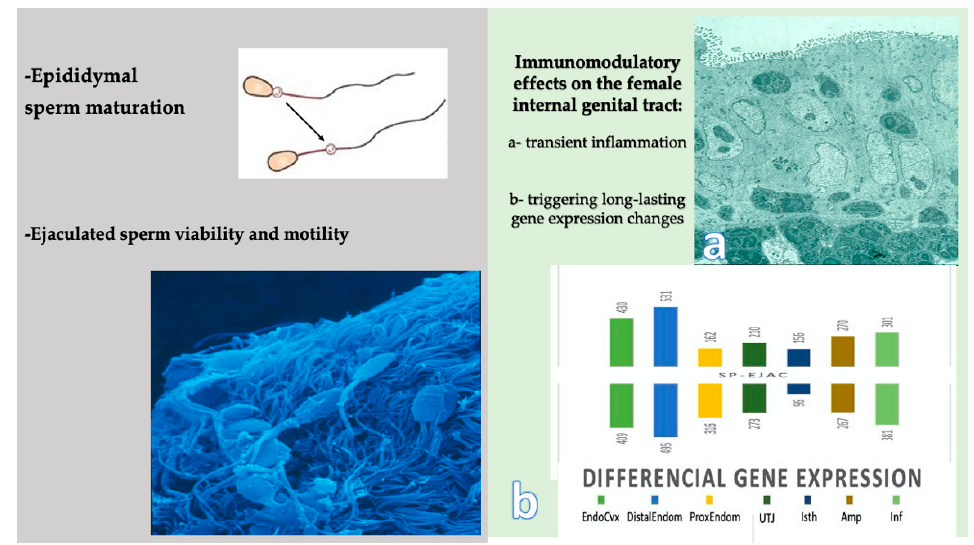
Figure 5. Major recognized functional effects of seminal plasma (SP) in vivo. In the male (left panel), the cytoplasmic sperm cytoplasmic droplet is lost at ejaculation, and SP promotes forward motility of the viable ejaculated spermatozoa along the female genital tract. In the female (right panel), SP elicits immunomodulatory effects in the genital tract, firstly through a migration of leukocytes from the lamina propria through the epithelium during an initial transient inflammation ( a ), concomitant with a triggering of long-lasting differential gene expression changes in the female ( b ): EndoCvx: endocervix; Distal-Prox Endom: distal/proximal endometrium; UTJ: utero-tubal junction; Isth: isthmus; Amp: ampullas; Inf: infundibulum.